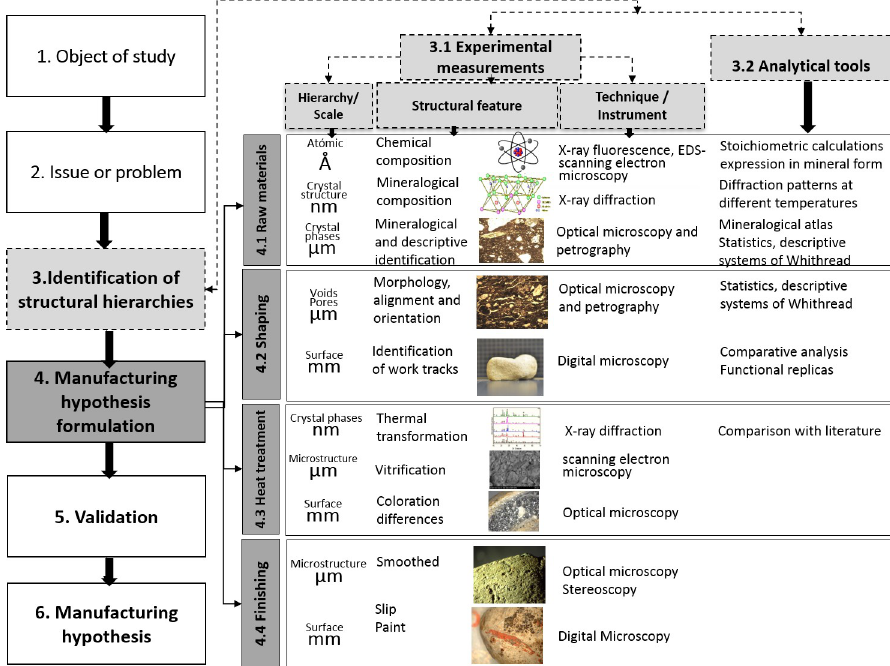
Fig 1. Methodological stages implemented to postulate the manufacturing hypotheses of the studied potsherds using a reverse engineering framework.